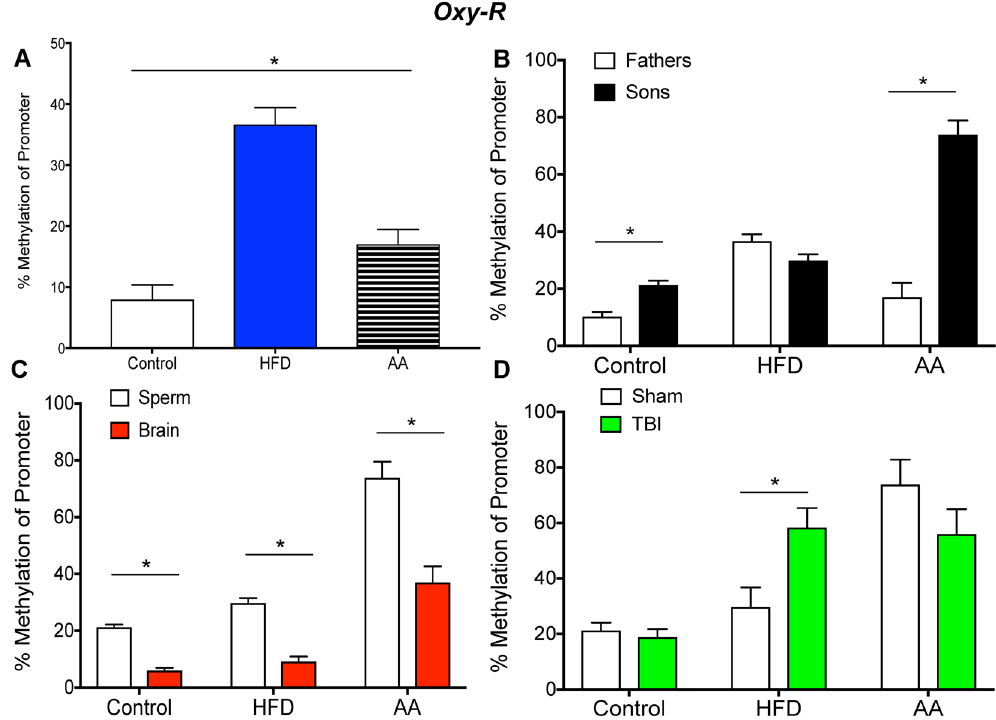
Figure 3. Illustrative demonstrations of Oxy-R promoter methylation. One way ANOVAs were conducted and significant main effects are indicated ( * p < 0.05). ( A ) Average Oxy-R promoter methylation in paternal sperm was significantly increased in HFD sperm compared to control and AA sperm ( p < 0.05). ( B ) Oxy-R promoter methylation was significantly increased in sperm of sons of control and AA fathers compared to paternal sperm ( p < 0.05). ( C ) Oxy-R methylation was significantly reduced in offspring brain compared to sperm in all three treatment groups ( p < 0.05). ( D ) Oxy-R methylation was significantly increased in mTBI sons compared to sham sons of HFD fathers ( p <